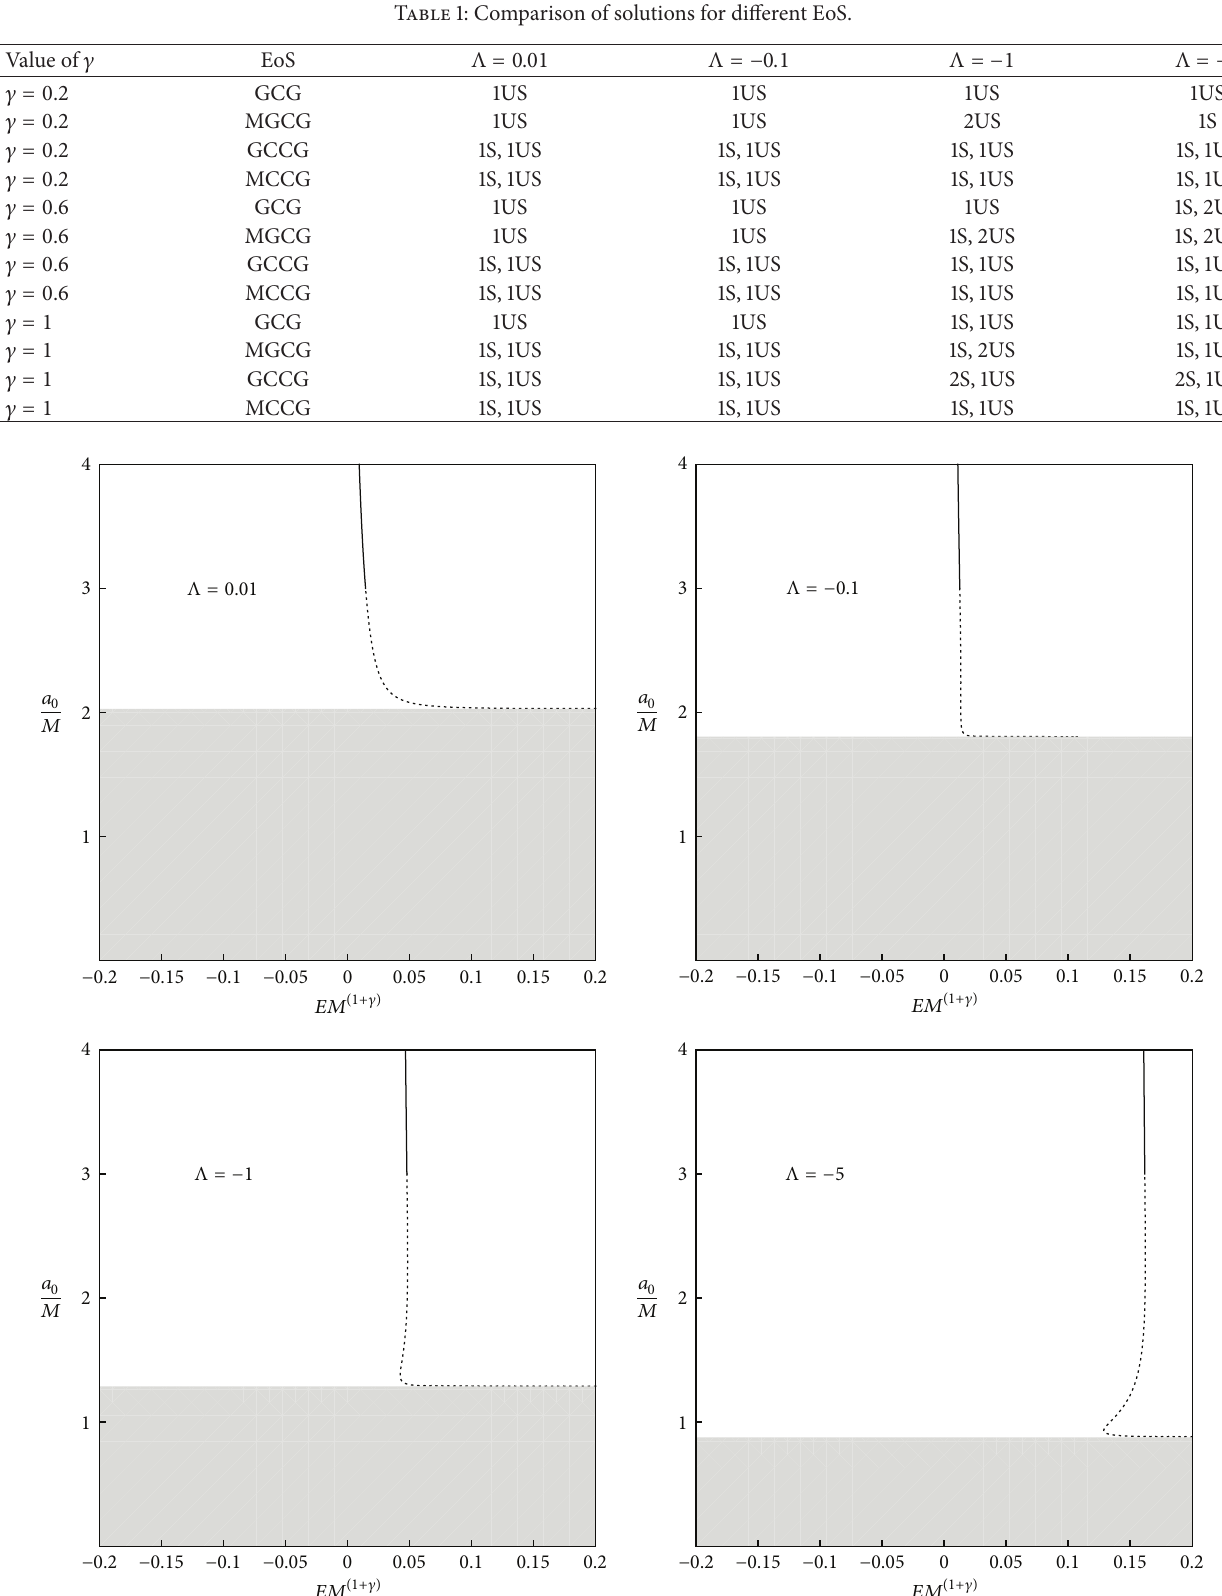
Figure 10: Plots with MCCG corresponding to 𝛾 = 1 , 𝑀 = 1 , 𝐴 = 1 , and 𝑤 = 0